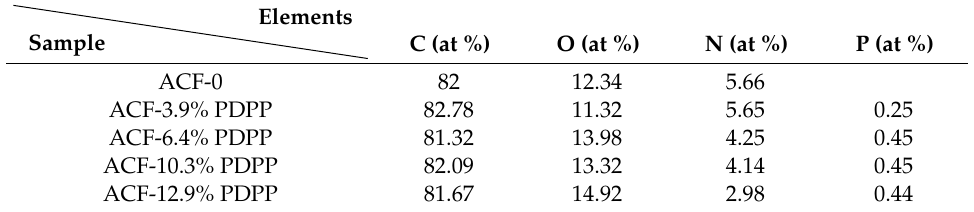
Table 4. Element content of ACFNs prepared from PAA-PDPP fibrous networks with di ff erent contents of